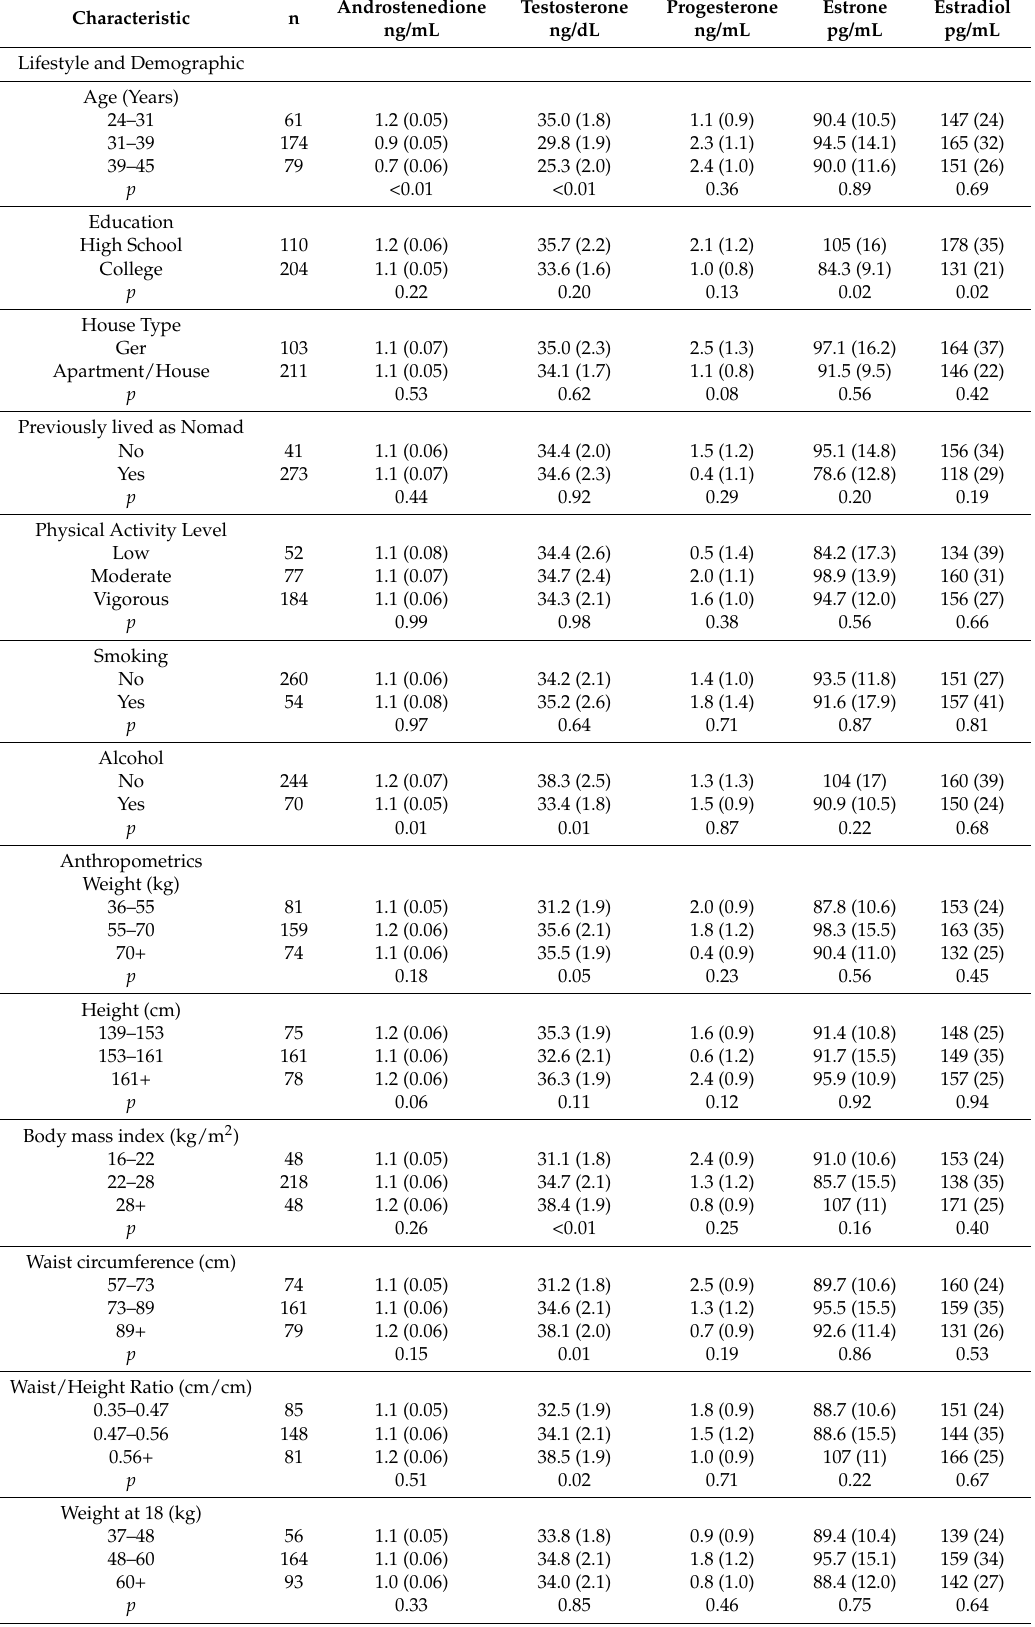
Table 2. Mean (SD) age-adjusted serum hormone concentrations over the menstrual cycle by anthropometric, reproductive, and lifestyle